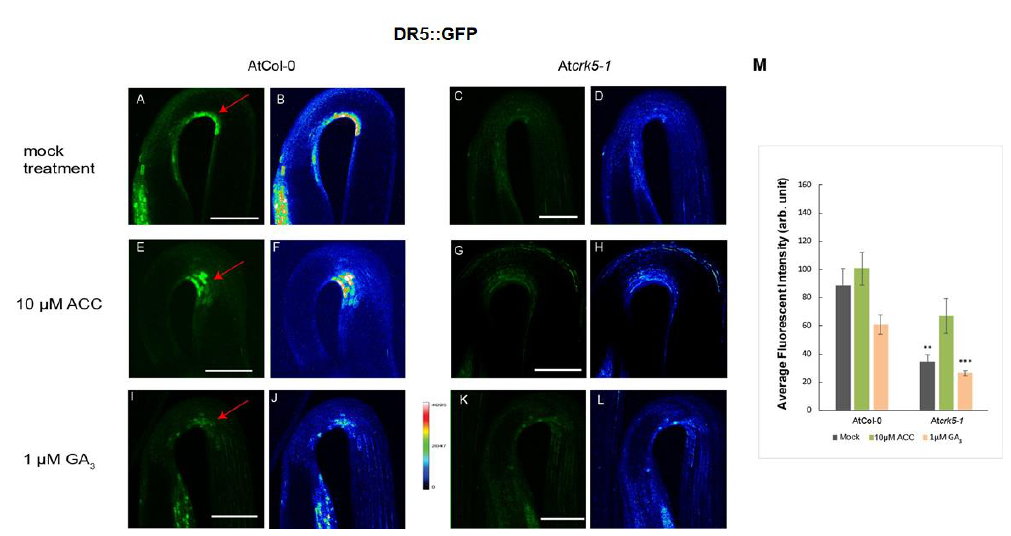
Figure 3. AtCRK5 regulates the hypocotyl hook auxin maximum. Distribution of the DR5::GFP signal in 3- days-old dark-grown Col-0 wild-type and mutant At crk5-1 seedlings treated with 10 μM ACC or 1 μM GA 3 . DR5::GFP signal is located at the concave side of the hypocotyl hook in the wild type ( A , B ) and it is much stronger than in the At crk5-1 seedling ( C , D ). Exogenous ACC enhances the DR5::GFP signal in the apical hook in the wild type ( E , F ) as well as in the mutant hooks ( G , H ). Red arrows point the GFP signals in the hook region. 1μM GA 3 treatment broadened the DR5::GFP signal at the apical hook of the wild type ( I , J ) and mutant ( K , L ). Figure 3B – D, F – H and J – L indicate the corresponding GFP signal intensity heat maps for the wild type and mutant, respectively. ( M ) Relative intensity of the DR5::GFP signals at the concave side of the hypocotyl hooks. 10 seedlings from wild type and mutant categories were investigated in each version. Asterisks indicate significant differences, compared with the corresponding Col-0 mock control and treatments (Student’s t- test, ** P < 0.001, *** P < 0.0001). All experiments were repeated for two times. Scale bars = 200 μm.